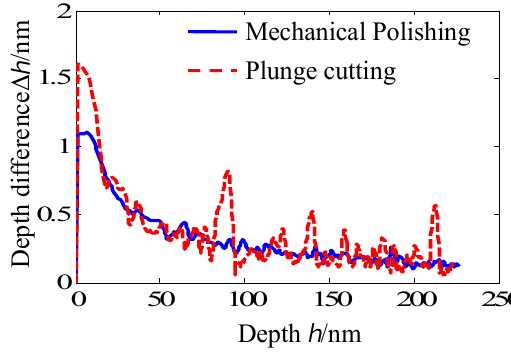
Figure 3. Depth difference Δ h sample preparation